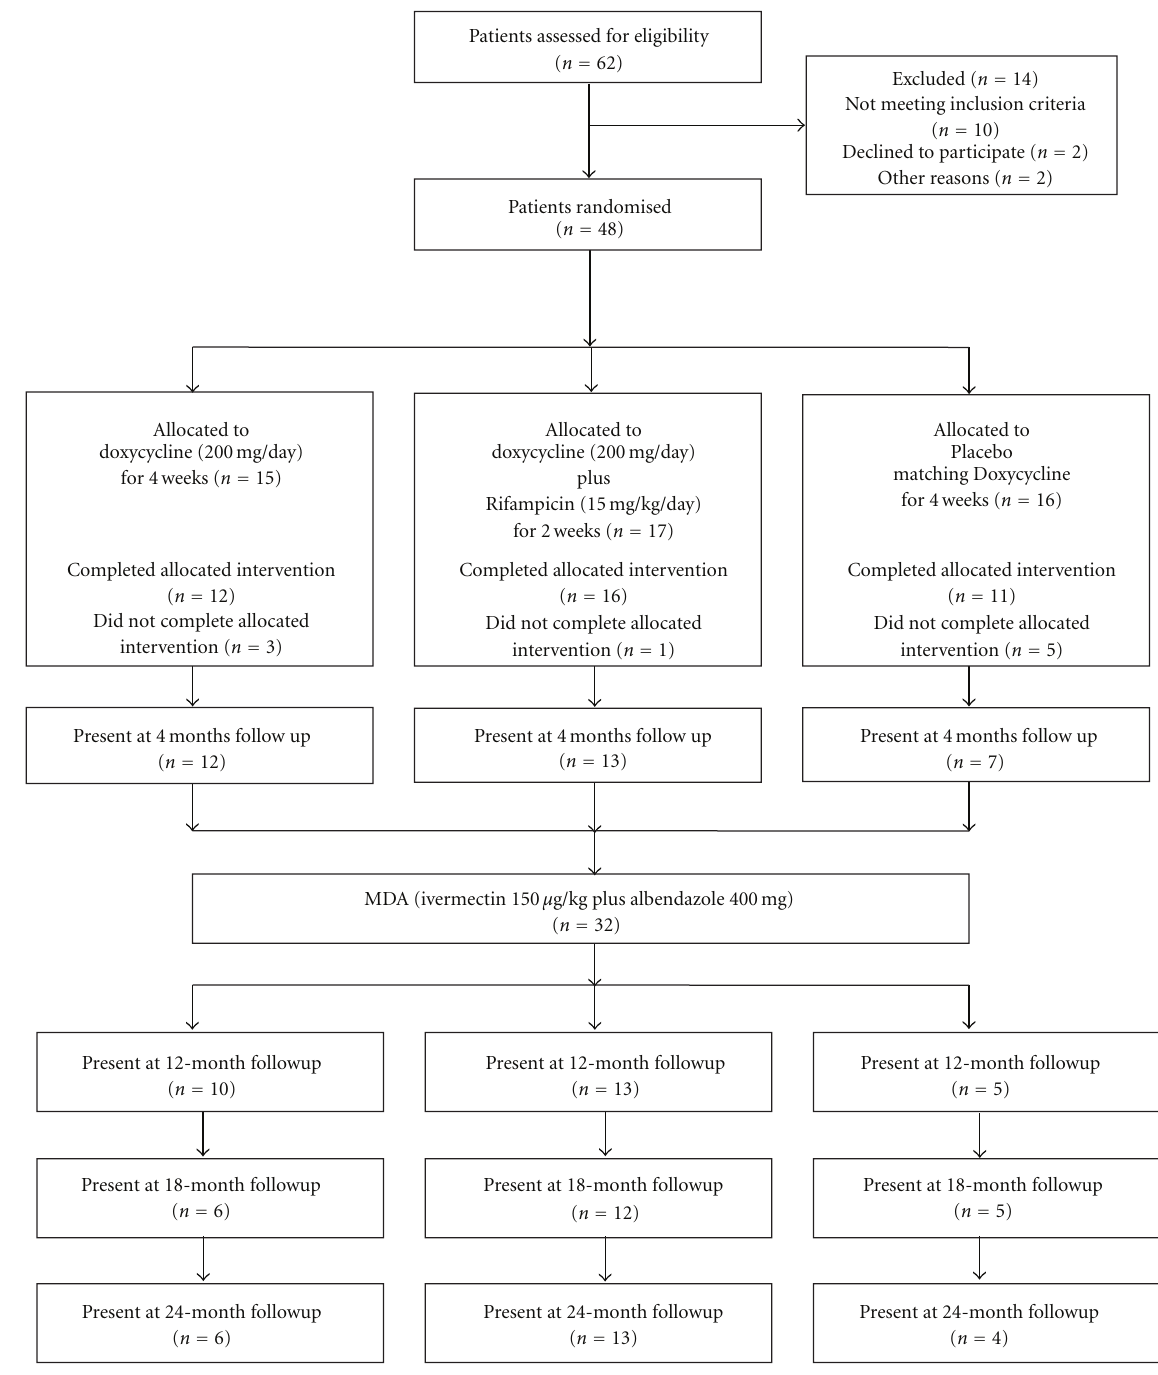
Figure 1: Recruitment and treatment profile of the pilot